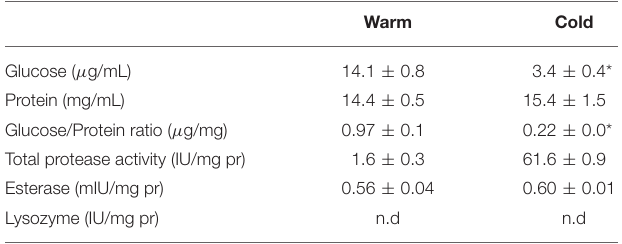
TABLE 3 | Metabolites and enzymatic parameters of epidermal mucus after a cold